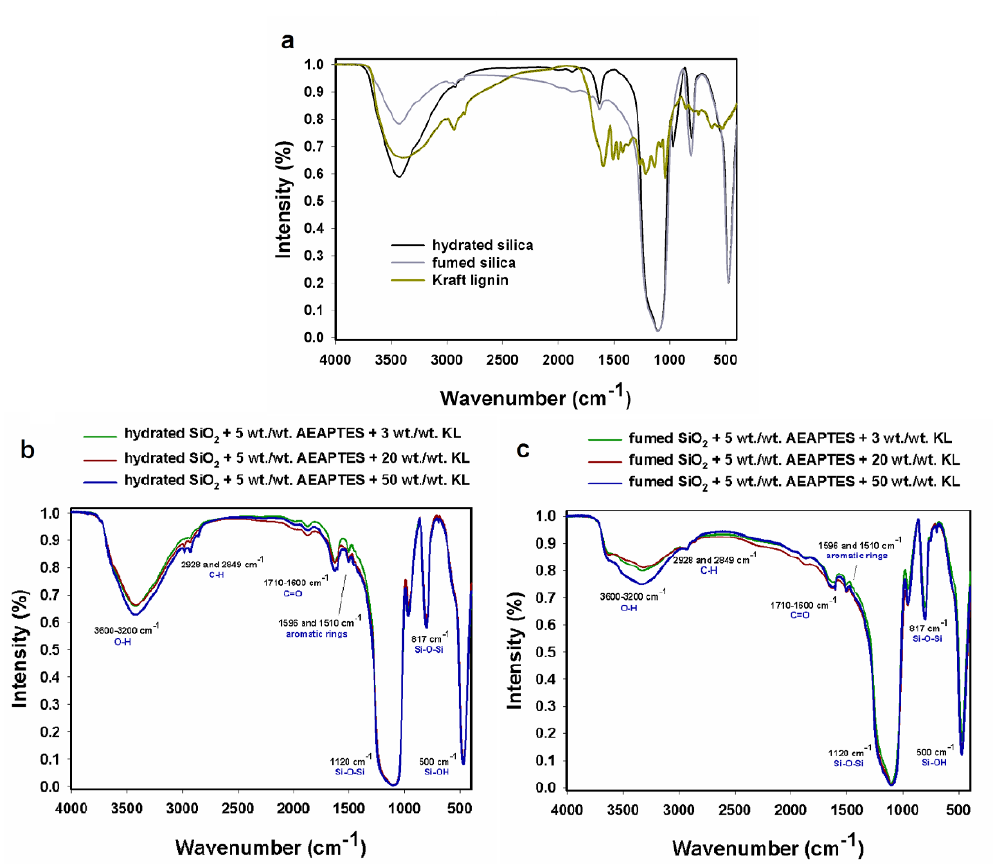
Figure 6. FT-IR spectra of unmodified silicas and Kraft lignin (a), and silica/lignin hybrid biomaterials prepared from hydrated silica (b) and Aerosil ® 200